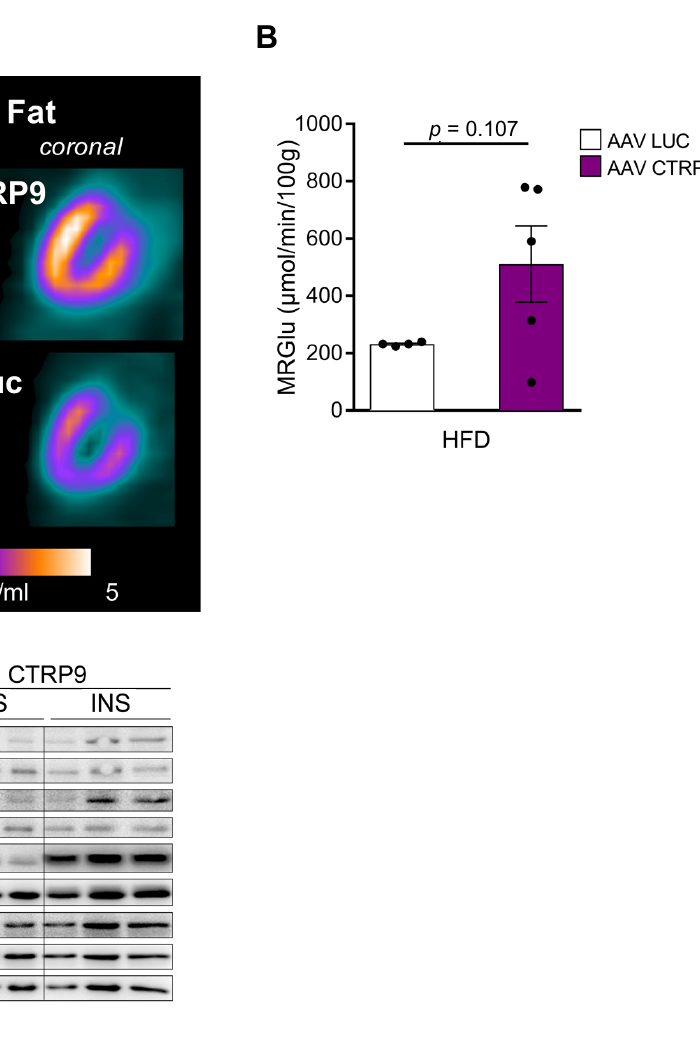
Figure 6. Overexpression of CTRP9 leads to increased glucose uptake in the heart during high-fat diet (HFD) administration. ( A ) Representative images of cardiac PET scans of the indicated HFD-fed mice treated either with AAV Luc (control) or AAV CTRP9 (leading to myocardial CTRP9 overexpression). 18 F-fluoro-deoxyglucose was used as a tracer. ( B ) Dynamic glucose uptake measured through PET scans as described in ( A ). ( C ) Immunoblot of cardiac protein lysate of mice treated as shown. GAPDH was used as a loading control. INS: insulin. Data are shown as mean ± standard error of the mean (SEM).